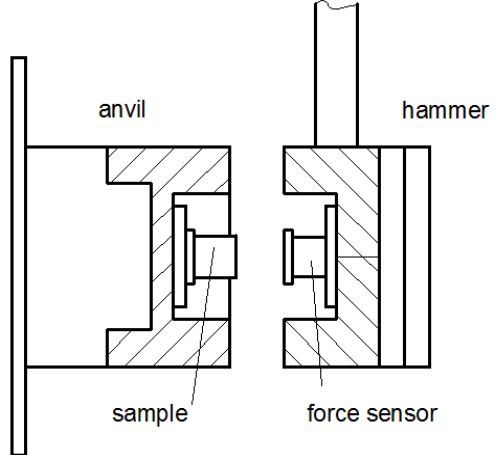
Figure 1. Impact measuring stand.